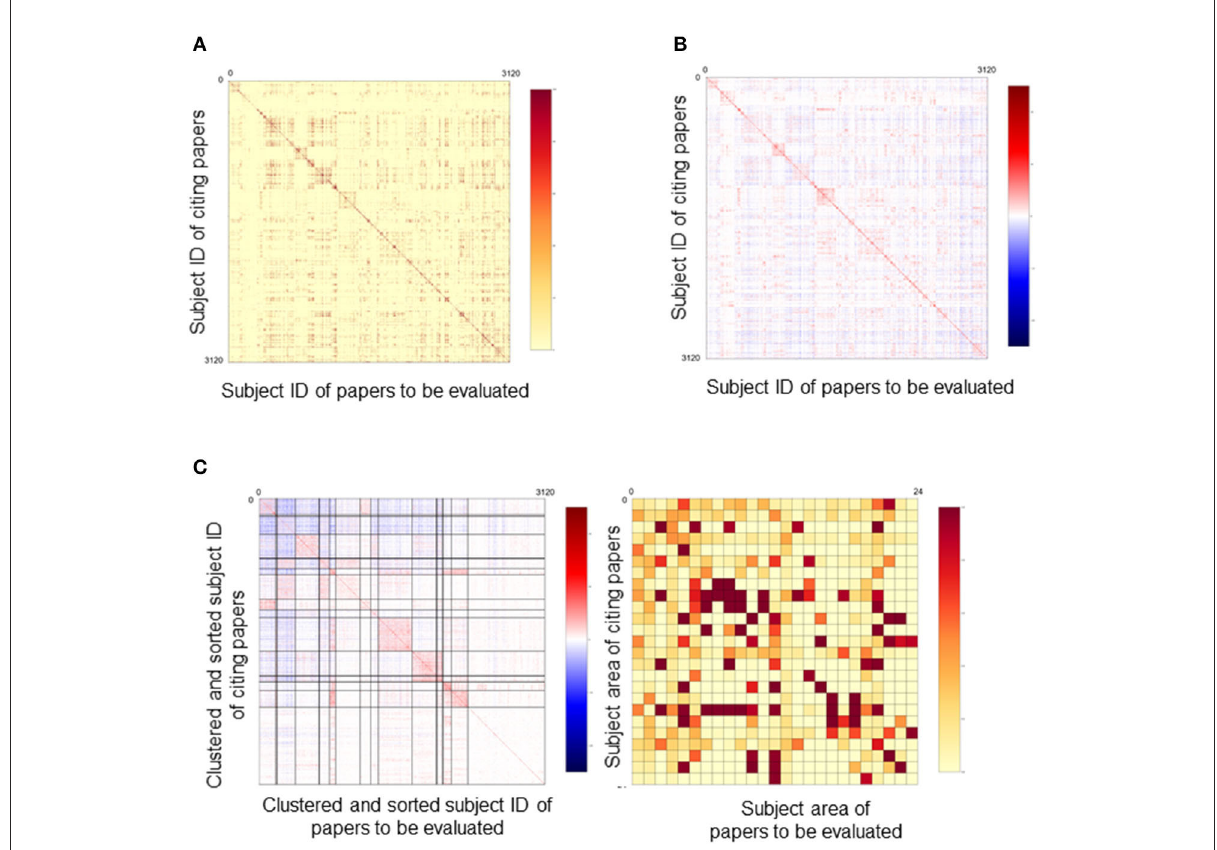
FIGURE3 Clustering of papers. (A) Adjacency matrix of the citation-citation network. About 3,200 aggregation patterns of class were detected. Each class is assigned a unique subject ID number. The number of citations for each element were shown in a color chart. Areas with a high number of citations are indicated in red. (B) Amount of Self Mutual Information (Pointwise Mutual Information), PMI. The adjacency matrix is normalized by PMI. Areas with a high number of citations are indicated in red. (C) Results of clustering by SBM. Clustered subject IDs were sorted and expressed as subject area by taking the average of Subject IDs contained in the cluster.